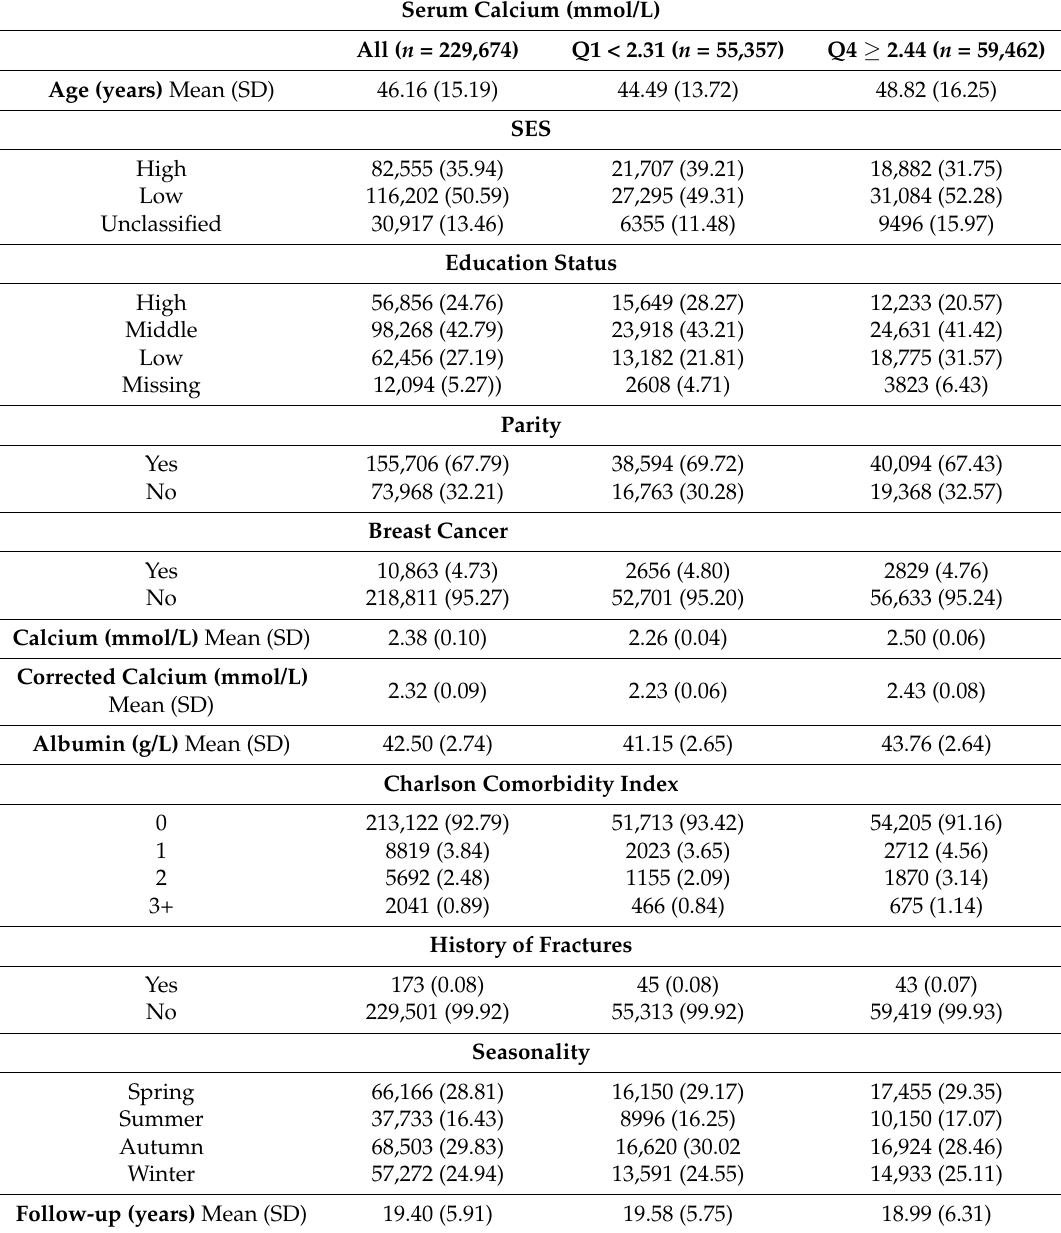
Table 1. Characteristics of study population in AMORIS, overall, and for the lowest and highest serum calcium